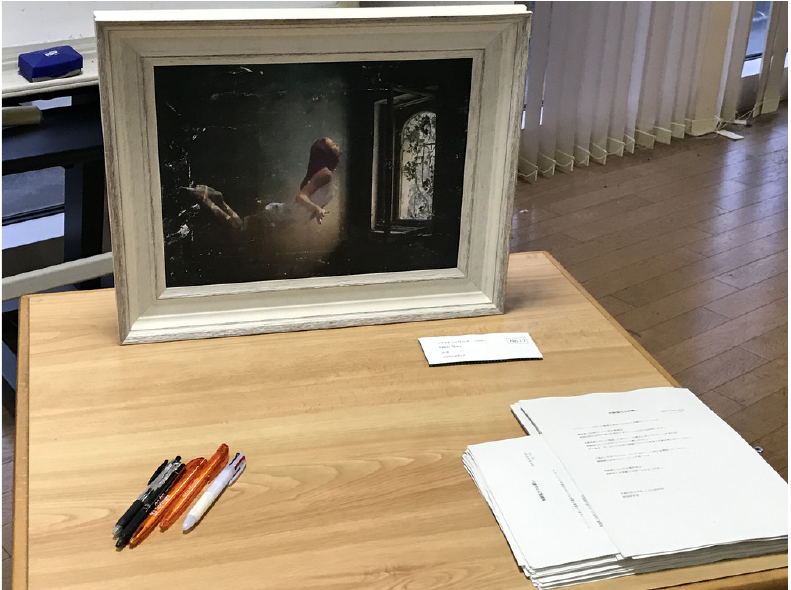
Figure 3. Experiment: using captions with several levels of